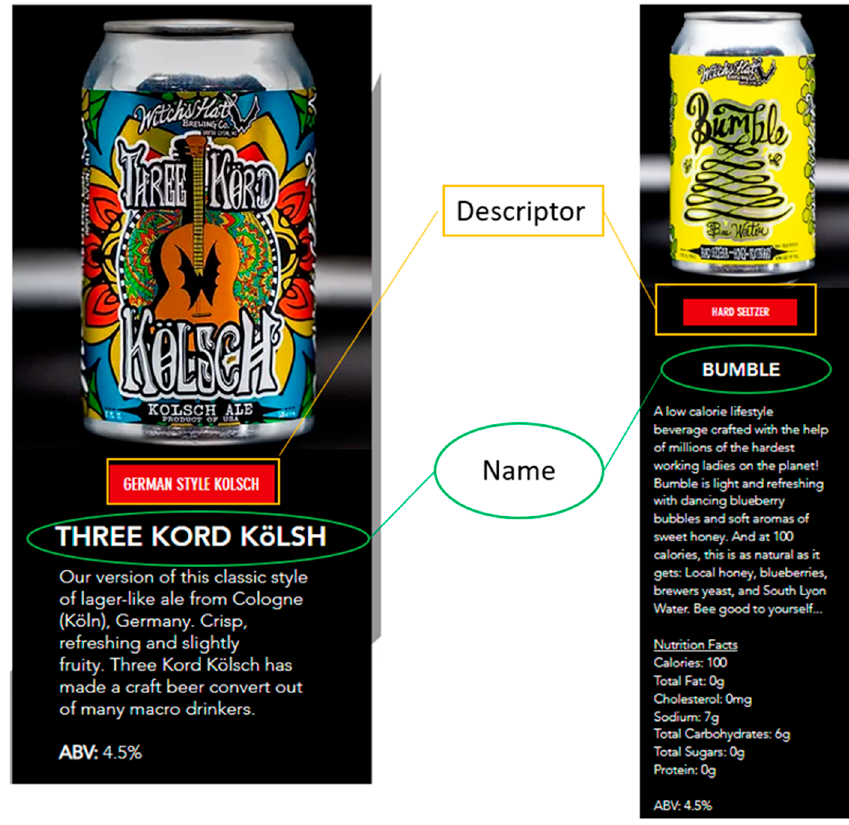
Figure 1. Examples of names and descriptors used for branding craft brewery offerings. (Screenshots collected by the authors from [https://www.witchshatbrewing.com/; accessed on 30 July 2022].).